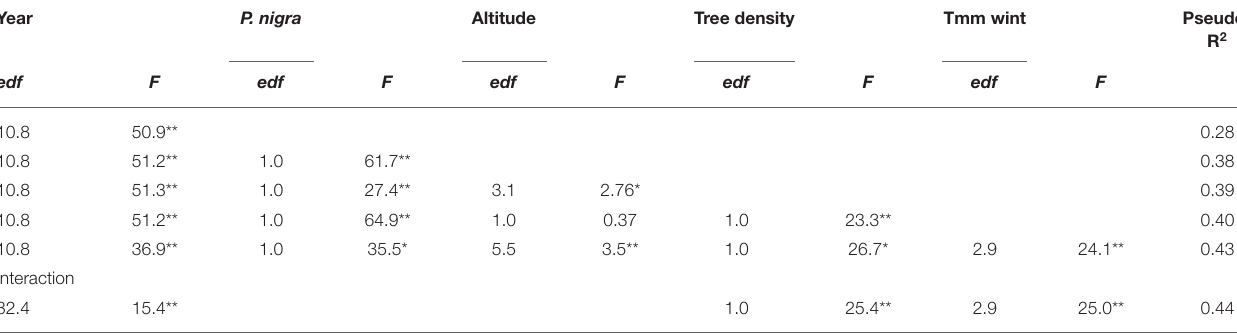
The last column shows the percentage of explained variance (pseudo R 2 ). The first model (first line) was created by using a cubic regression splines for calendar year (the degrees of freedom, edf, and F statistics are shown). After that, the rest of covariates were included: P. nigra, relative abundance of P. nigra; altitude; tree density; Tmm wint, average winter minimum temperature. The last line shows the model with a spatiotemporal interaction between year, P. nigra abundance and altitude. Significance levels: * P < 0.05; ** P < 0.01.